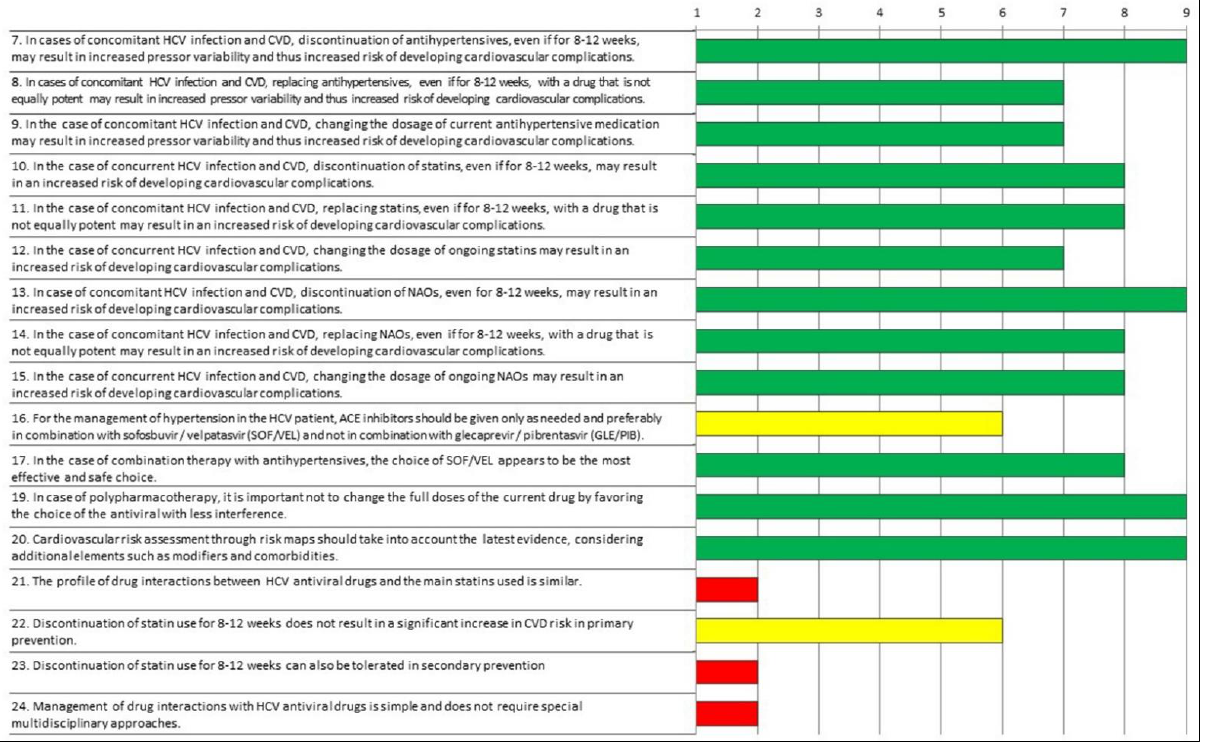
Figure 1. Appropriateness of responses to Questionnaire 1 evaluated according to the RAND/UCLA Method. Green: appropriate; yellow: uncertain; red: inappropriate.